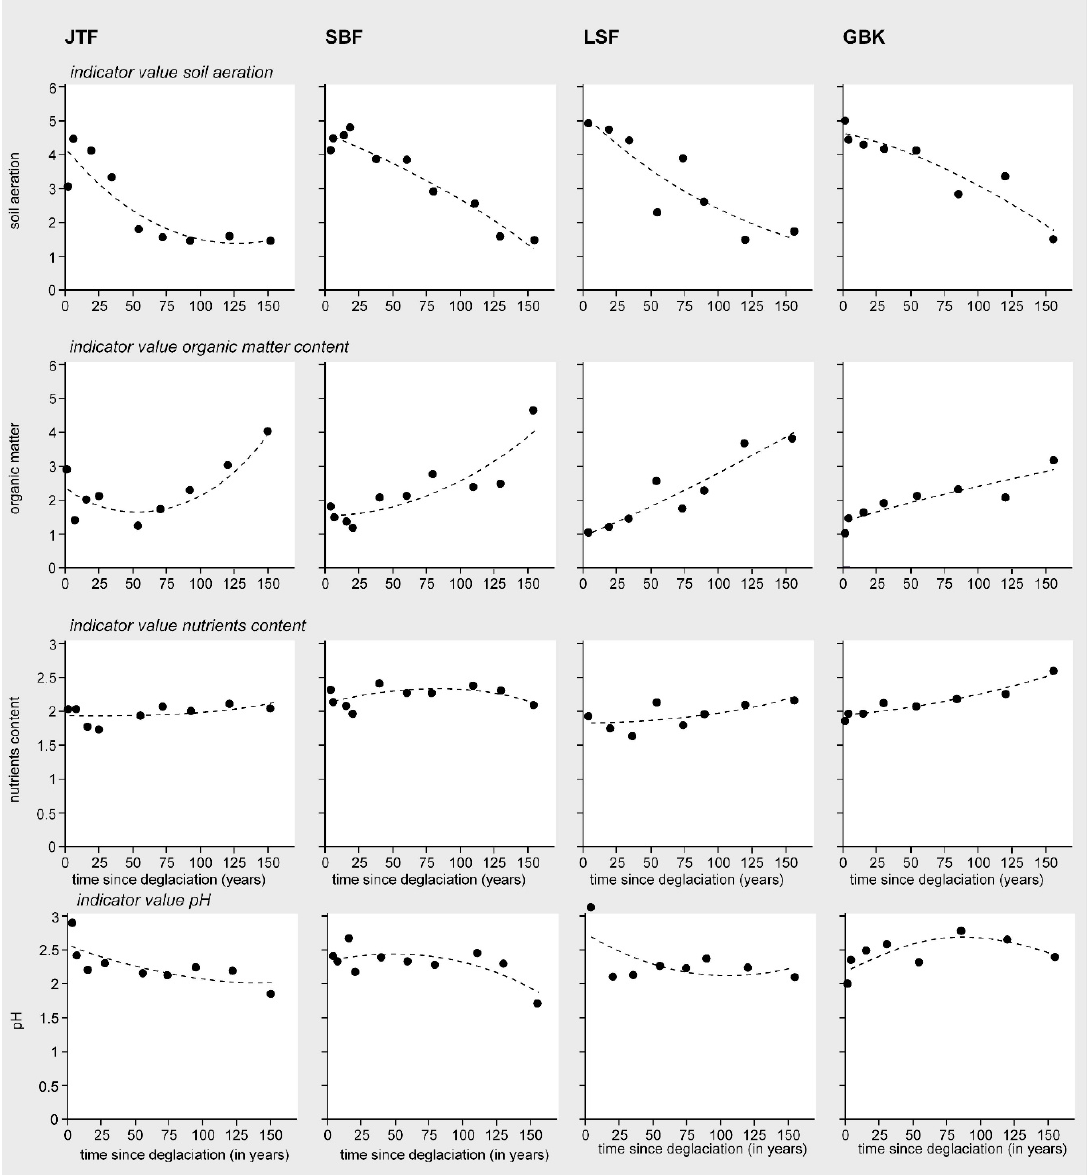
Figure 6. Change of edaphic traits scores with time since deglaciation within the four glacier forelands studied. The values are cover-weighted averages of sample locations according to [46,47] .